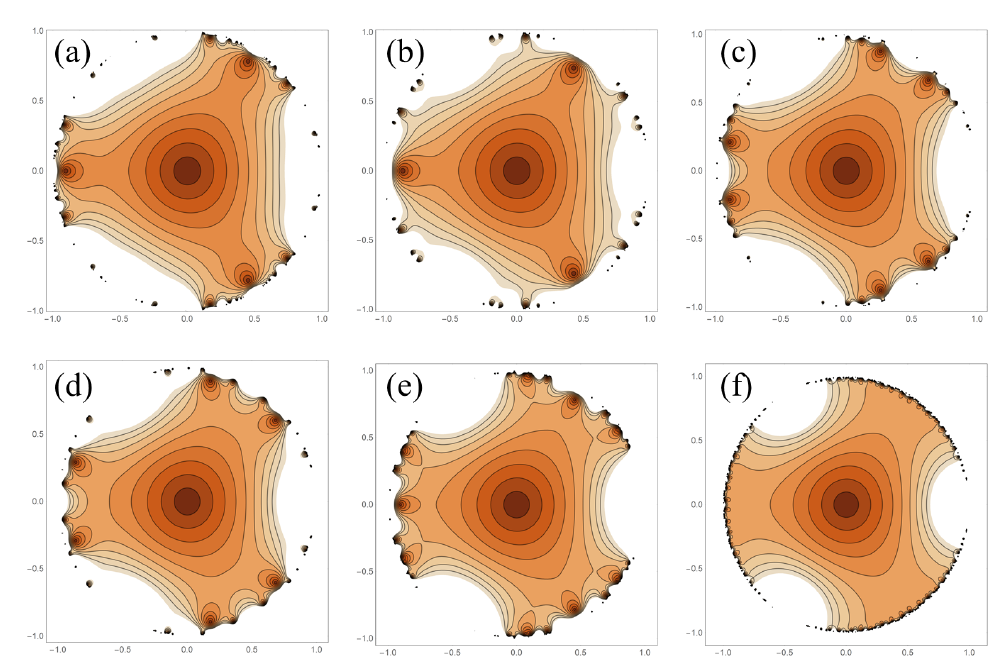
Figure 5. A sequence of related lacunary functions that systematically vary the rate of gap increase. (cid:106) (cid:107) ( n − 1 ) + ( n − 1 ) 2 Here, h ( n ) = . In all cases, k = 3 and N = 200. Across the top row from left to right: w ( a ) w = 1, ( b ) w = 3, and ( c ) w = 6. Across the bottom row from left to right: ( d ) w = 8, ( e ) w = 9, and ( f ) w = 500. At low values of w (rapid growth of the gap), one sees significant qualitative changes in the graphs for modest changes in w . At higher values of w , the qualitative features of the graph stabilize. There is a general trend from higher convexity of the domain bounded by the the main unity contour to lower convexity. (Note: a very small positive value (1 × 10 − 6 ) is added to w during the rendering to ensure h ( 1 ) = 1 when w =